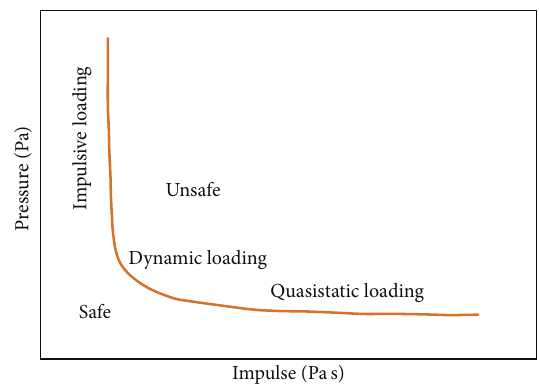
Figure 5: PI diagram: impulsive, dynamic, and quasistatic loading.